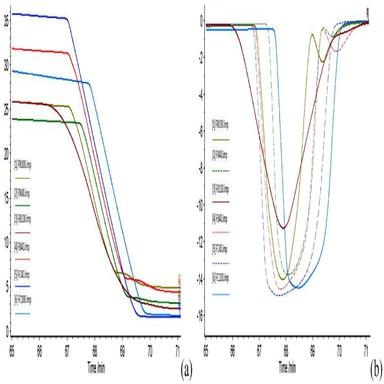
TG (a) and DTG (b) curves for the burning at 700 ◦C of pyrolysis char from fir.